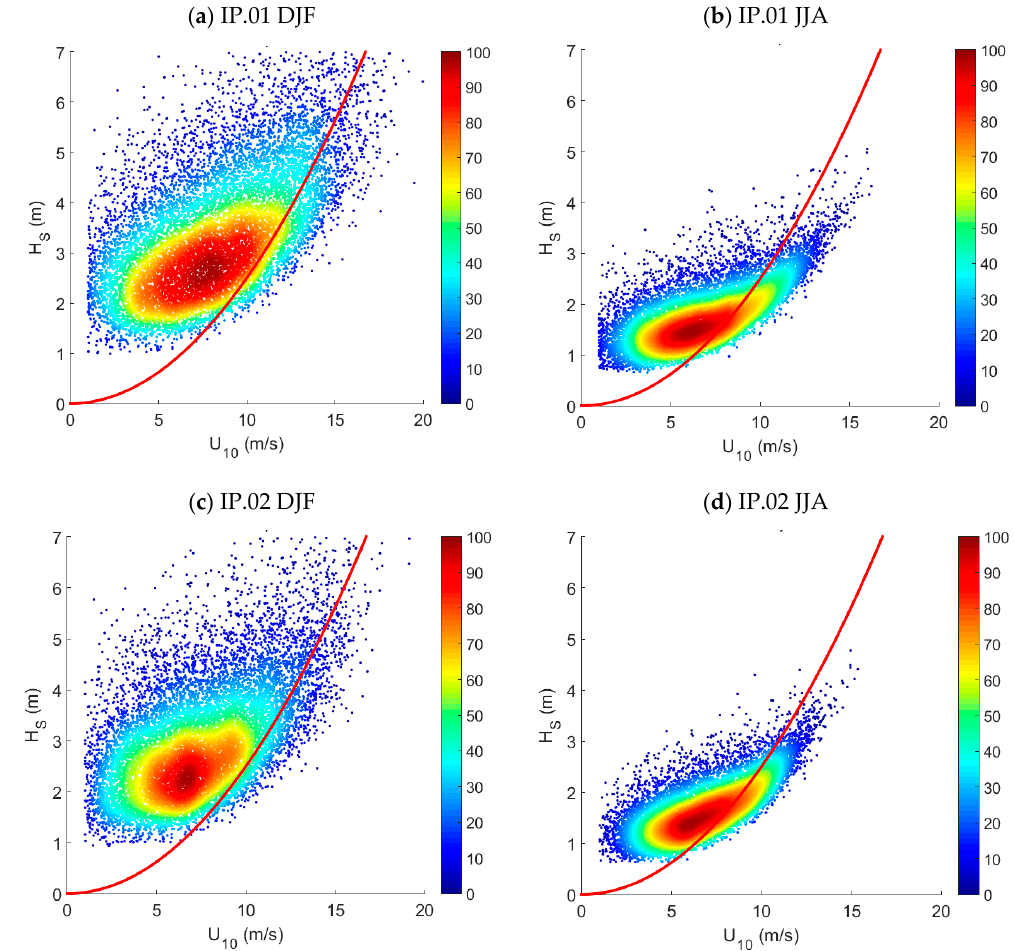
Figure 11. Scatter diagrams of U 10 (ms − 1 ) and H s (m) for position and IP.01 (at 42 ◦ N–11 ◦ W) for ( a ) DJF and ( b ) JJA, and for key position IP.02 (at 38 ◦ N–11 ◦ W) for ( c ) DJF and ( d ) JJA. The color density in the scatter plots represents the data density normalized by the maximum values, and the overlayed red lines represent the Pierson Moskowitz theoretical relation between U 10 and H s , a defined in Equation (4), for fully developed seas.